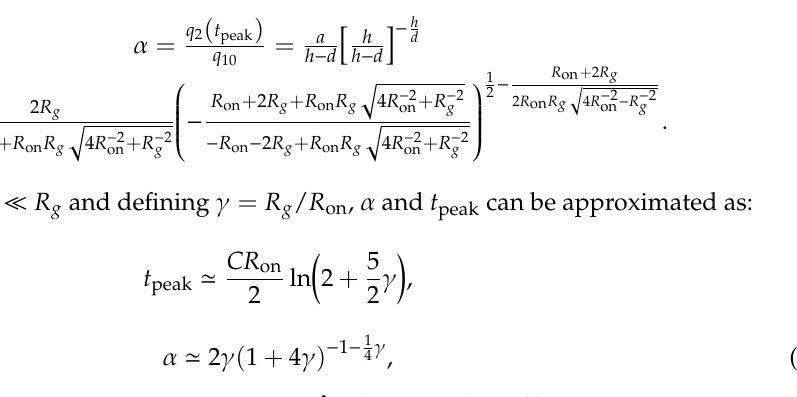
Figure 5. ( a,b ) Relationship between 𝛾, 𝛼, and 𝑡 peak ̂ .